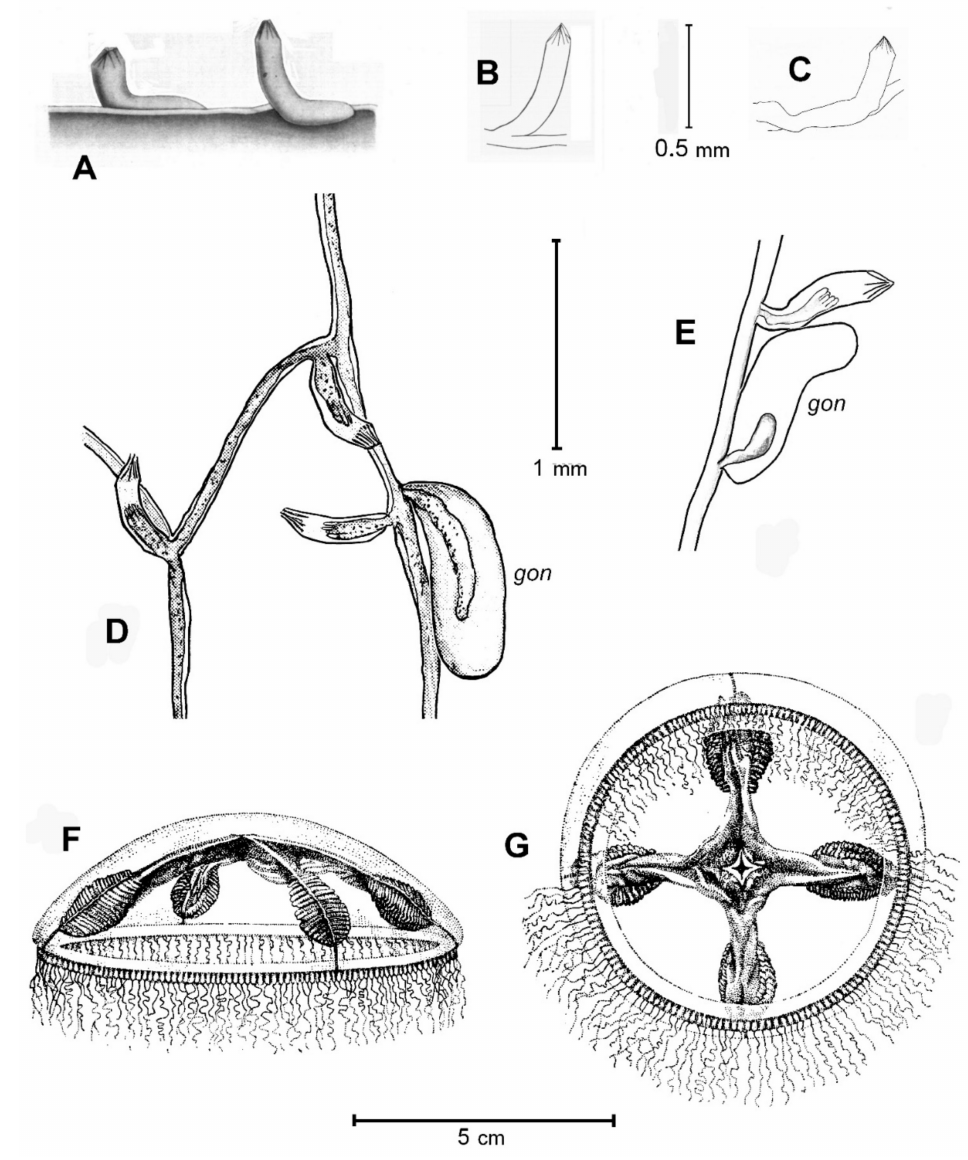
Figure 1. Ptychogena lactea A. Agassiz, 1865; hydroid and medusa ( A – G ). Hydroid Cuspidella procumbens Kramp, 1911. ( A )—after [11] (type material; Greenland); ( B )—after [12] (NE Canada); ( C )—after [13] (pictured from the type material of Kramp); ( D , E )—after [7] (material from Franz-Josef Land; gon — gonotheca). Medusa Ptychogena lactea A. Agassiz, 1865. ( F – G )—after [1] (Barents